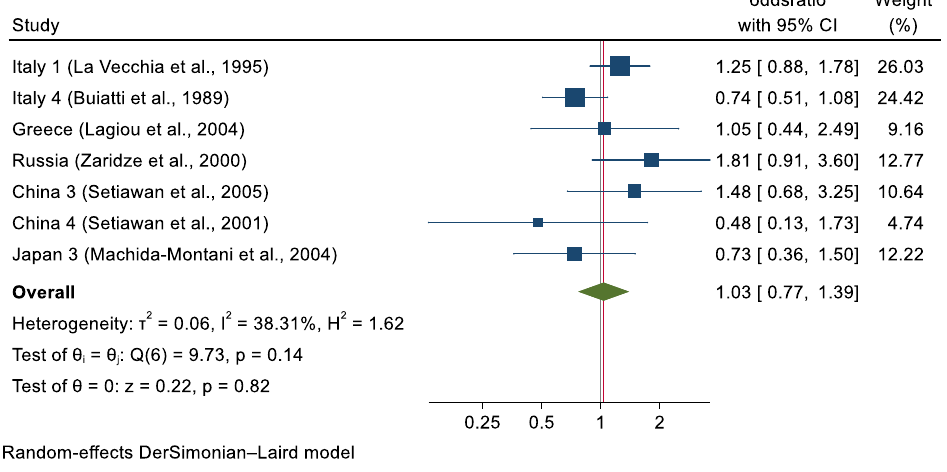
Figure 2. Study-specific and Pooled ORs for the Overall Association Between History of duodenal Ulcer and Gastric Cancer.